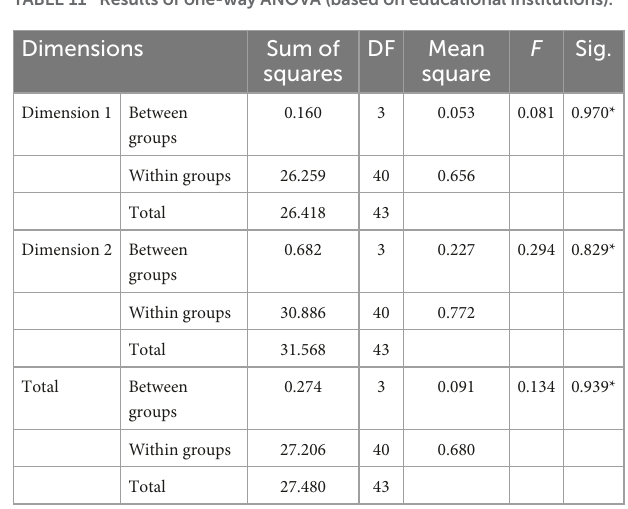
TABLE 11 Results of one-way ANOVA (based on educational